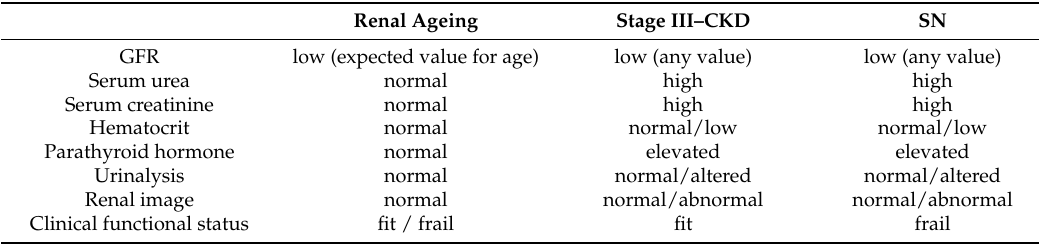
Table 1. Clinical guide for distinguishing an aged kidney from a chronically damaged one. Renal